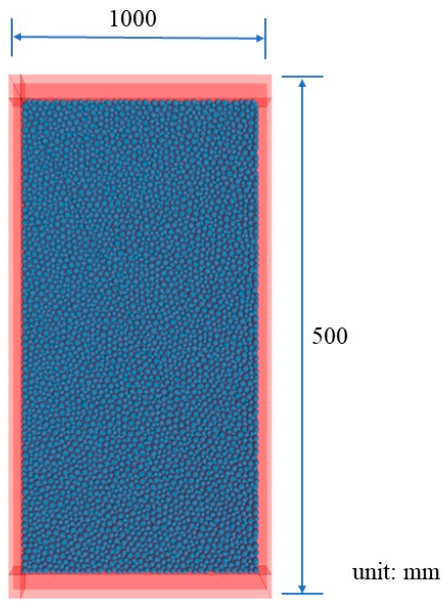
Figure 10. Numerical simulation model.